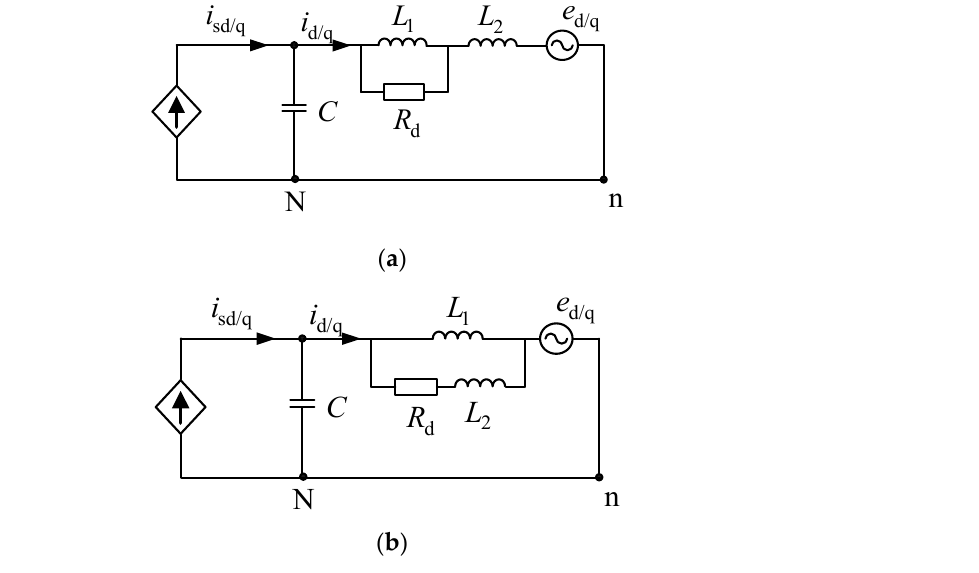
Figure 5. Proposed split-inductor passive damping topology. ( a ) Solution 1; ( b ) Solution 2.